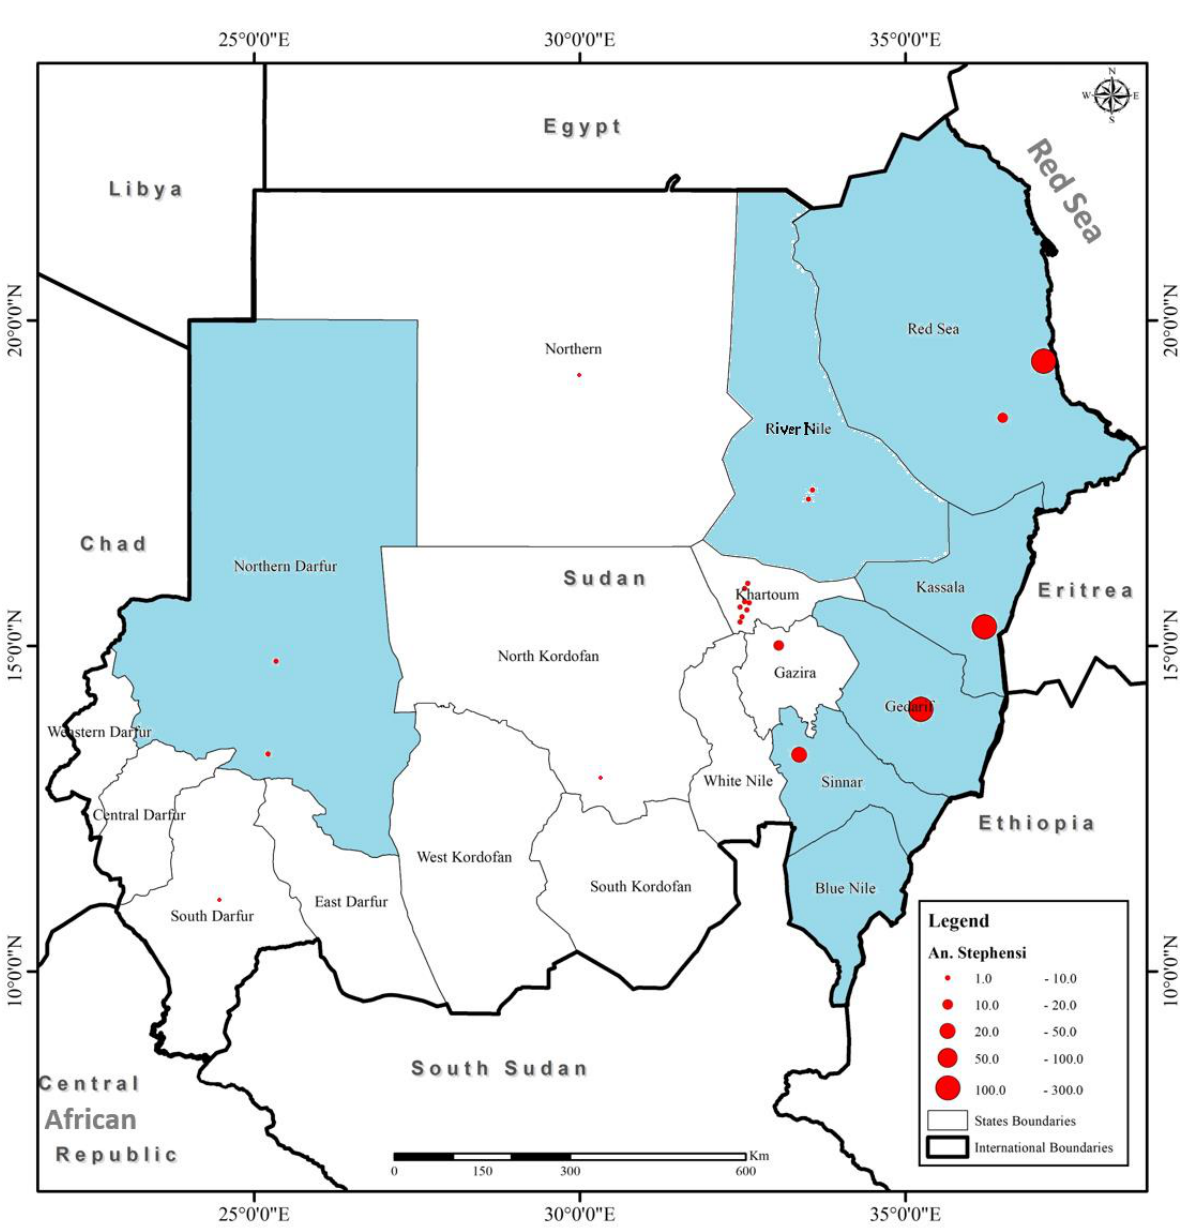
Figure 1. Sudanese States (highlighted in light blue) where active surveys were implemented to detect An. stephensi mosquitoes. The red circles indicate the number of An. stephensi mosquitoes col- lected.